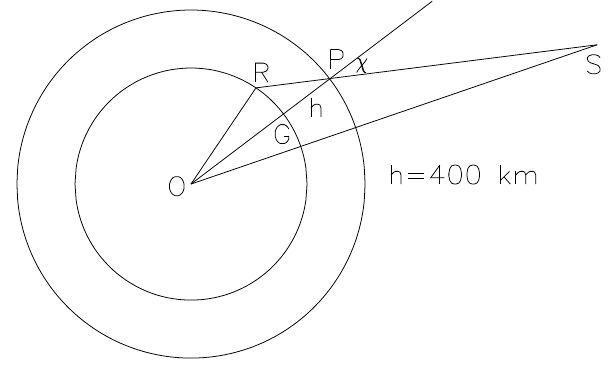
Fig. 1. Geometry of a GPS satellite ( S ), the ionosphere, and a re- ceiver ( R ). While the total electron content is retained, the iono- sphere is assumed to be a screen sphere lying at the height of 400km from the ground. Here, P represents the intersection of the line of sight and the ionosphere, χ is zenith